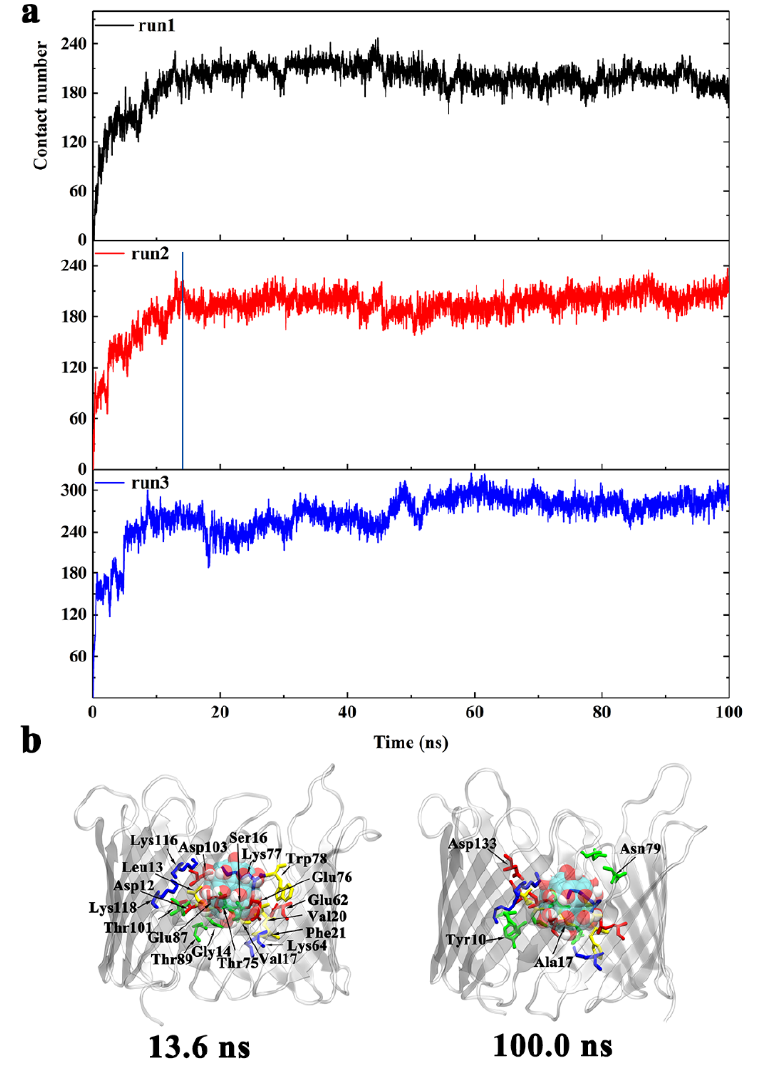
Figure 4. ( a ) The evolution of the total number of atomic contacts between hVDAC1 and Gd@C 82 (OH) 22 molecules that penetrated the channel from OM in runs 1–3. The blue line represents key time points of the protein–nanoparticle interactions. ( b ) The binding conformations of Gd@C 82 (OH) 22 to hVDAC1 at key time points corresponding to ( a ) as well as the final conformation. The key residues that contact Gd@C 82 (OH) 22 are labeled and colored according to the residue type. 3.2. Binding Interactions and Kinetics of Gd@C 82 (OH) 22 Entering the Lumen of hVDAC1 from the IM